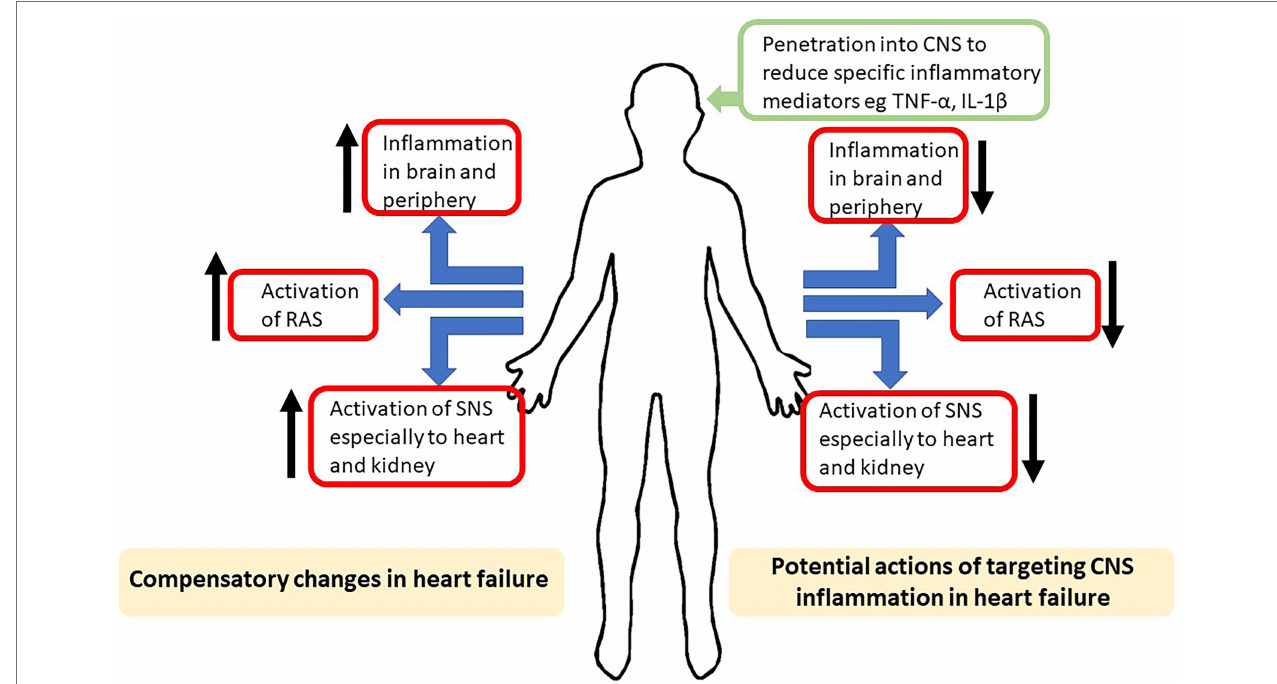
FIGURE 1 | Schematic highlighting, on the left side, the compensatory increases in inflammation, activation of the renin–angiotensin system (RAS) and activation of sympathetic nerve system (SNS) induced by heart failure. On the right is shown the potential actions on the compensatory mechanisms of drugs aimed at reducing the actions of inflammatory mediators in the central nervous system